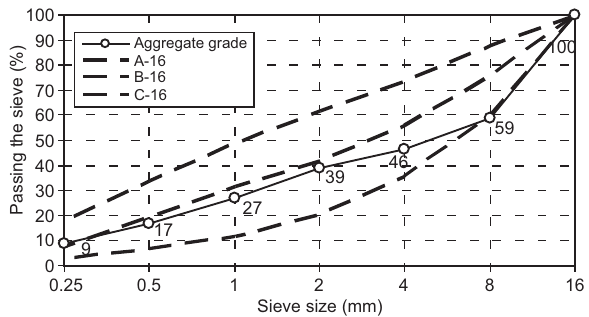
Figure 1 Aggregate grading used in the